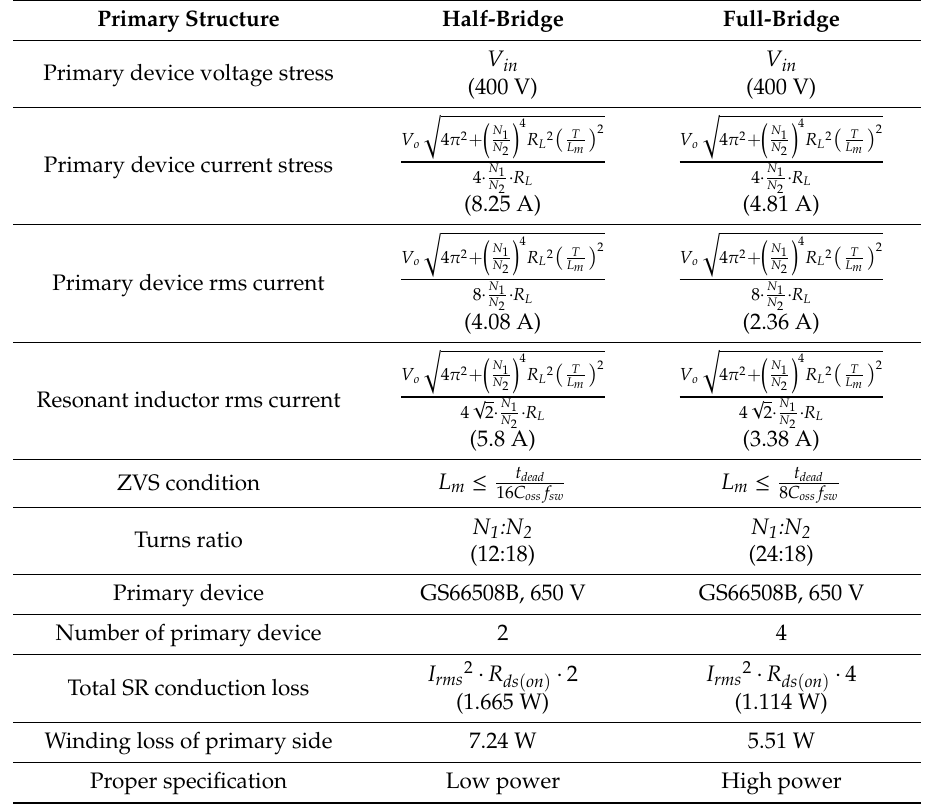
Table 1. Comparison of primary-side